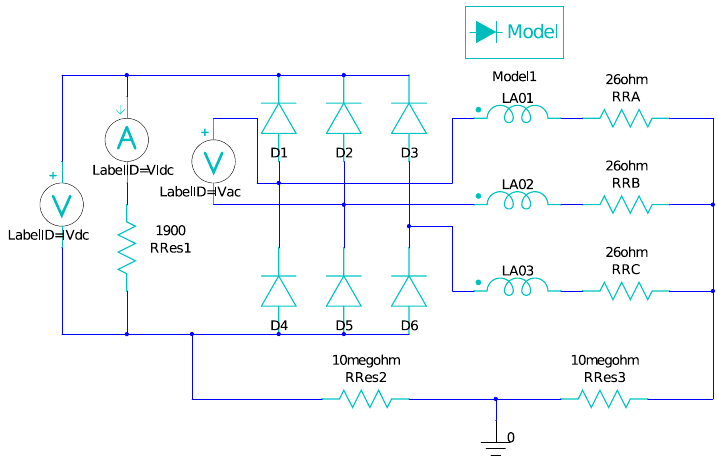
Figure 8. FEM analysis circuit model for the transient simulations.